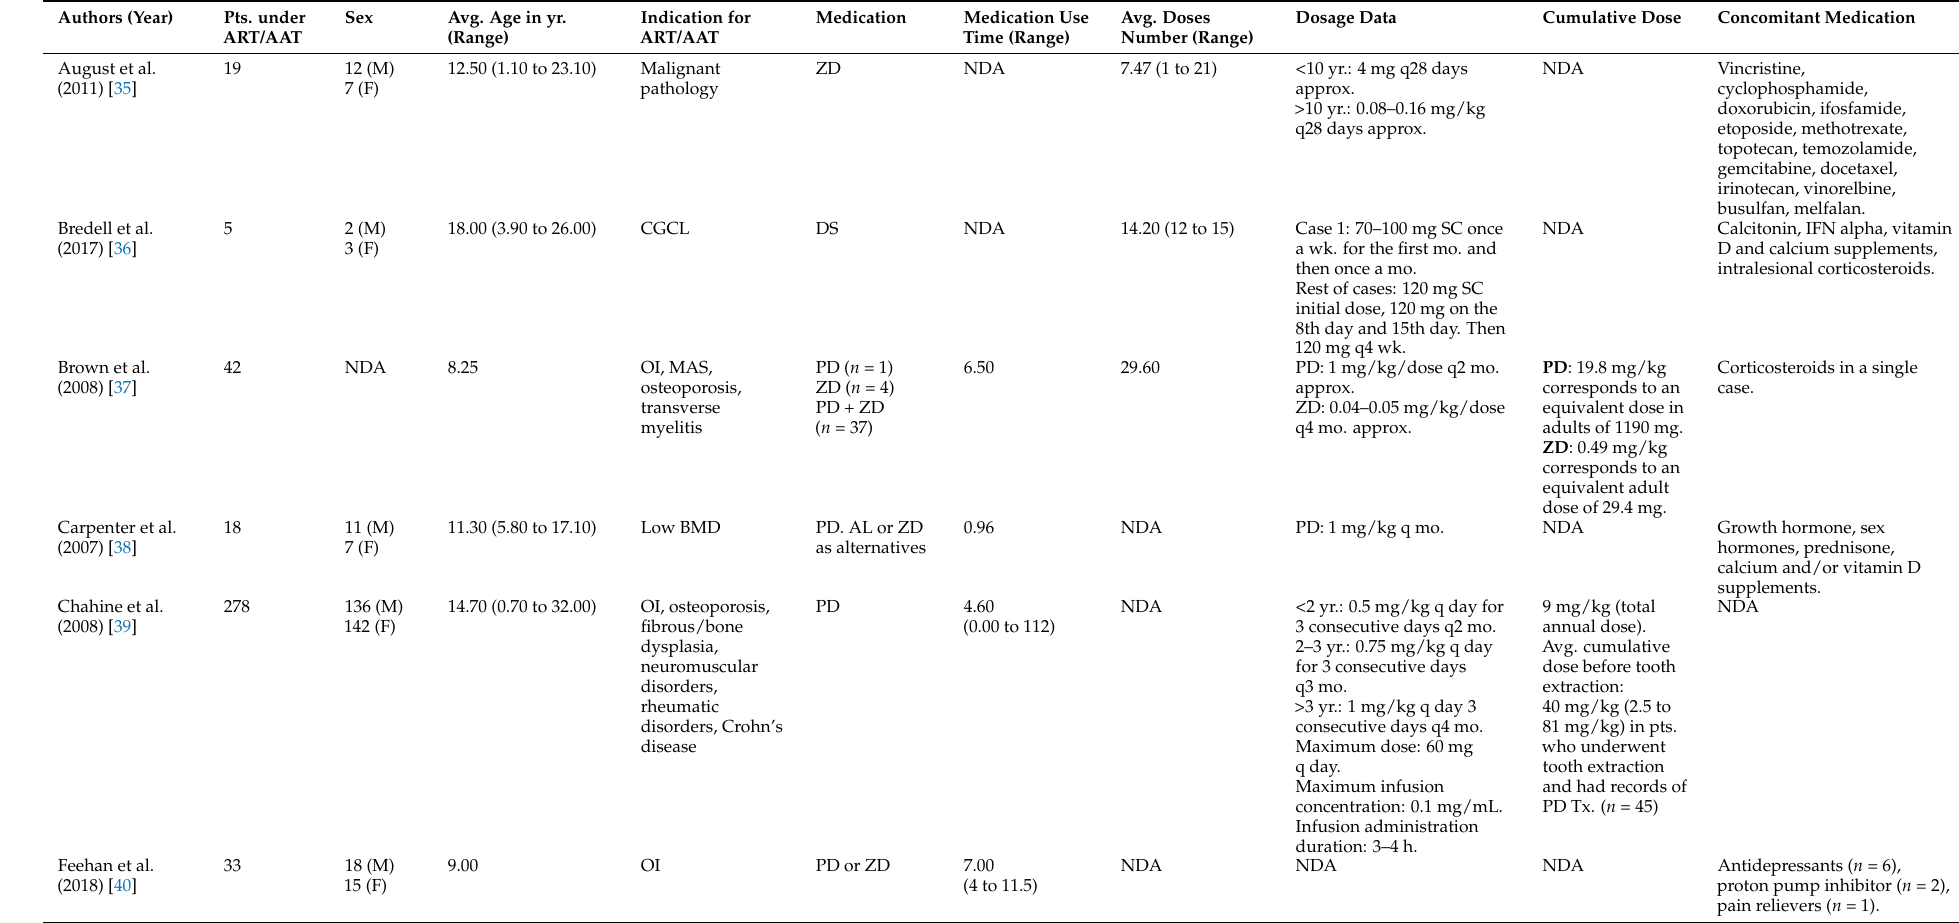
Table 1. Distribution of variables of 29 articles related to MRONJ included in this systematic